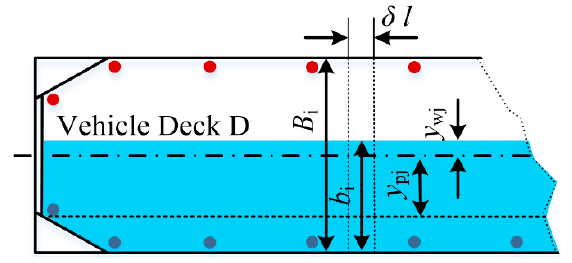
Figure 4. Illustration of the firewater computation.